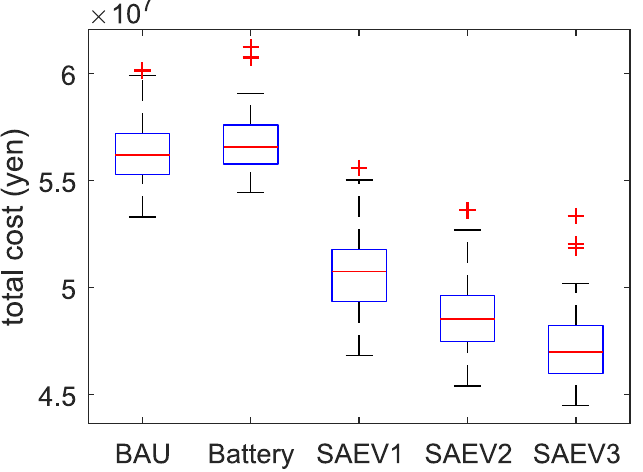
Figure 8. Weekly average total costs for the cases considered in the microgrid case.